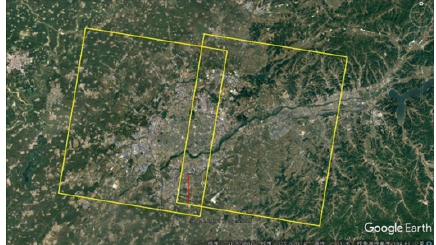
Figure 1.Coverage of the CSK images(yellow